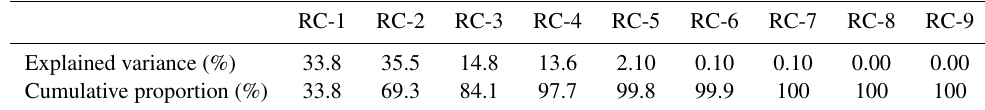
Table 3. Explained variance and cumulative explained variance by different components obtained from the RC analysis.